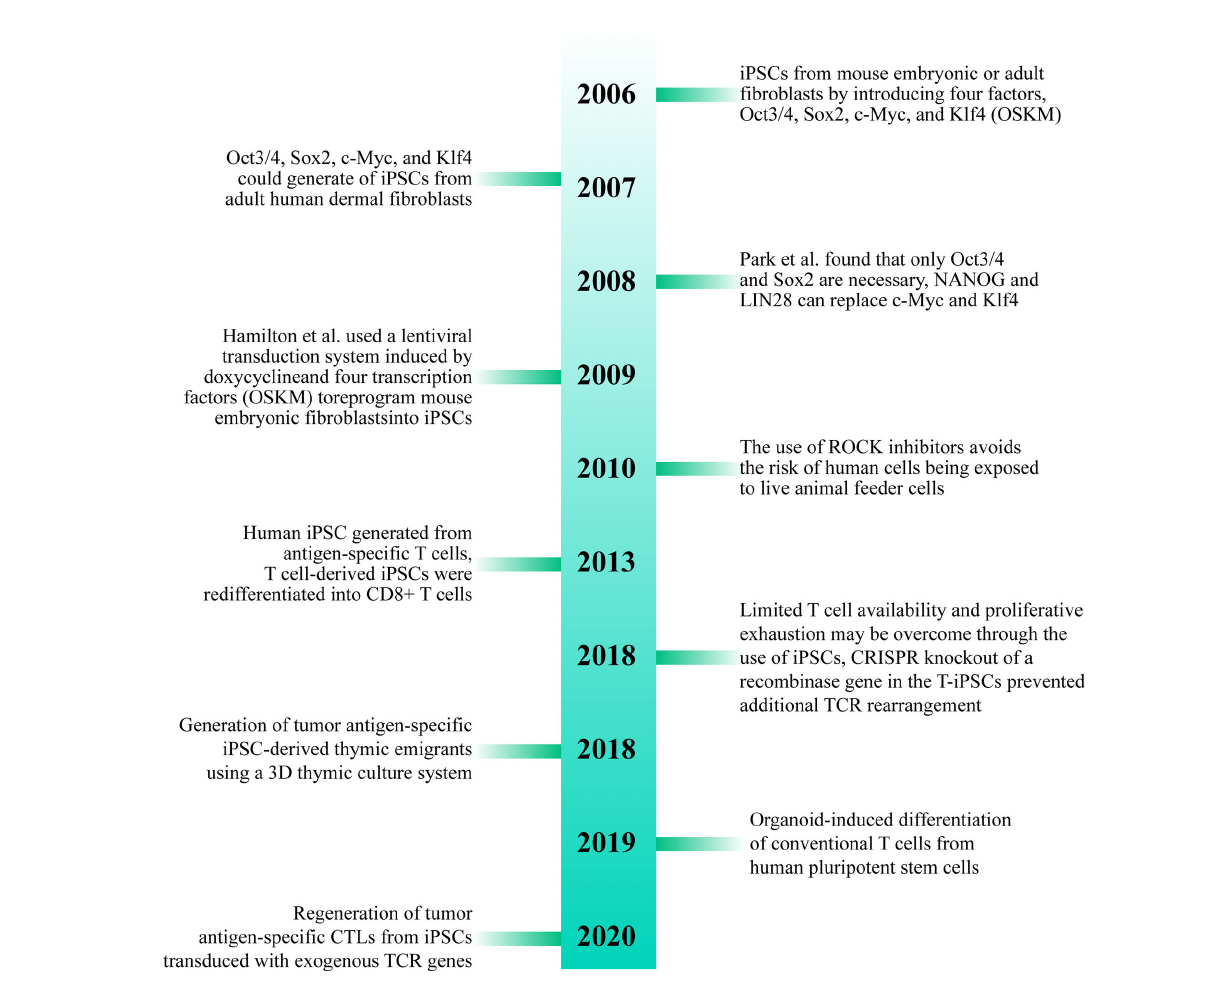
FIGURE 3 | Brief history of T cell-derived induced pluripotent stem cells (T-iPSCs). TCR, T Cell Receptor; iPSCs, induced pluripotent stem cells; CTLs, cytotoxic T